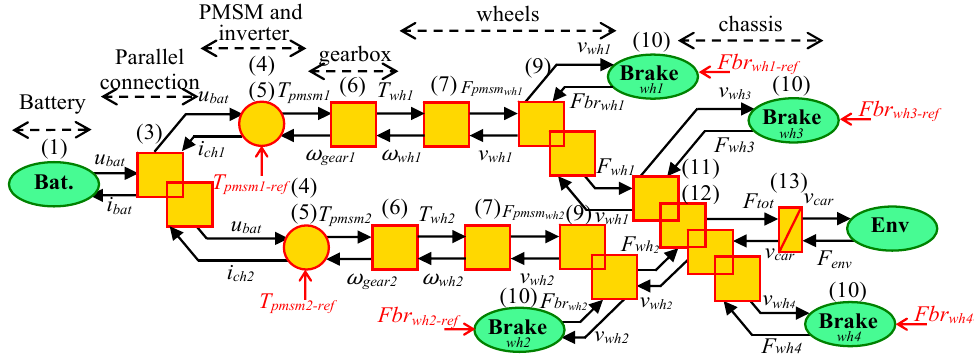
Figure 3. Complete EMR representation of studied car.